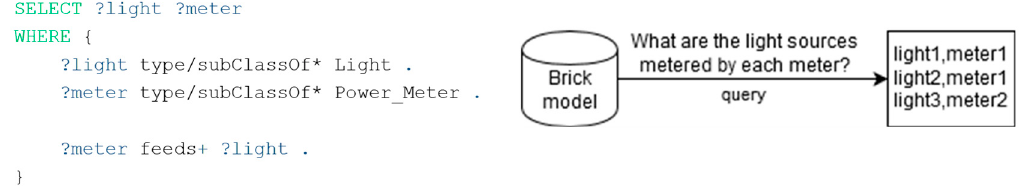
Figure 6. Query for collecting the sets of lights being fed by each meter in SPARQL on the left. The sets are constructed from individual pairs in post processing. An illustration of the query question and example results on the right.